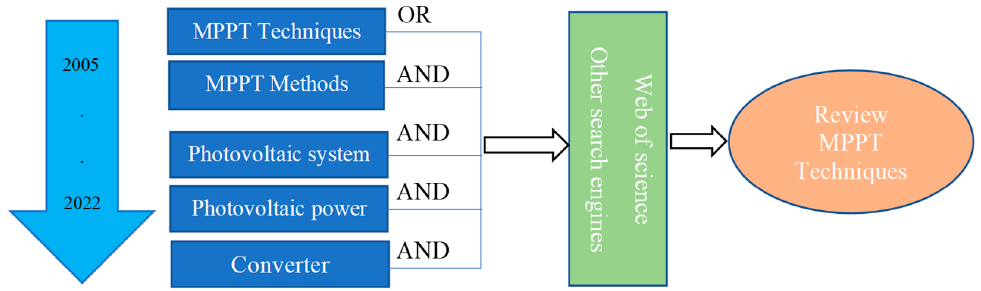
Figure 2. Search methodology based on keyword combinations using Boolean operators AND/OR.